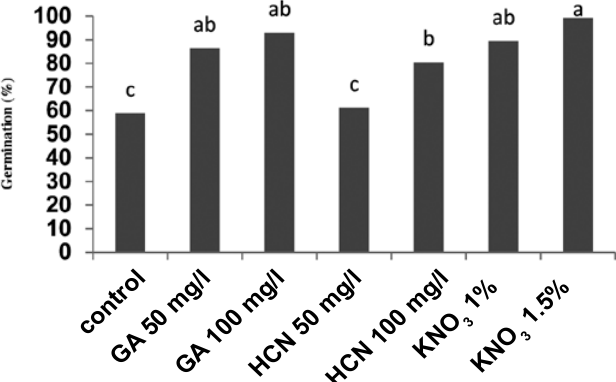
Fig. 6 - Effect of different priming agents on cumulative germination percentage (G ) of Shahpasand pistachio max